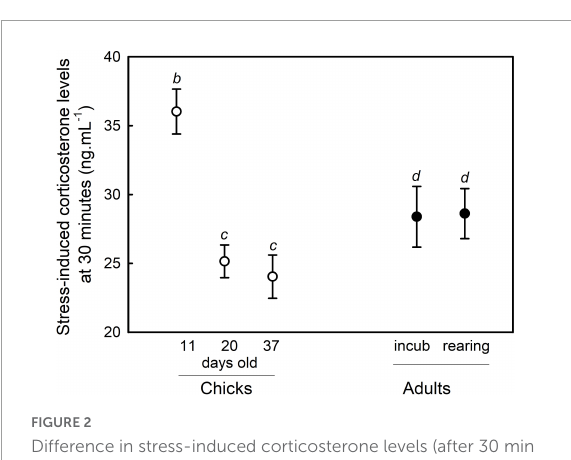
FIGURE2 Difference in stress-induced corticosterone levels (after 30 min of restraint) between 11-days old chicks, 20-days old chicks, 37-days old chicks, incubating adults, and chick-rearing adults. Mean ± SE are represented and different letters indicate significant differences. White and black symbols represent chicks and adults,